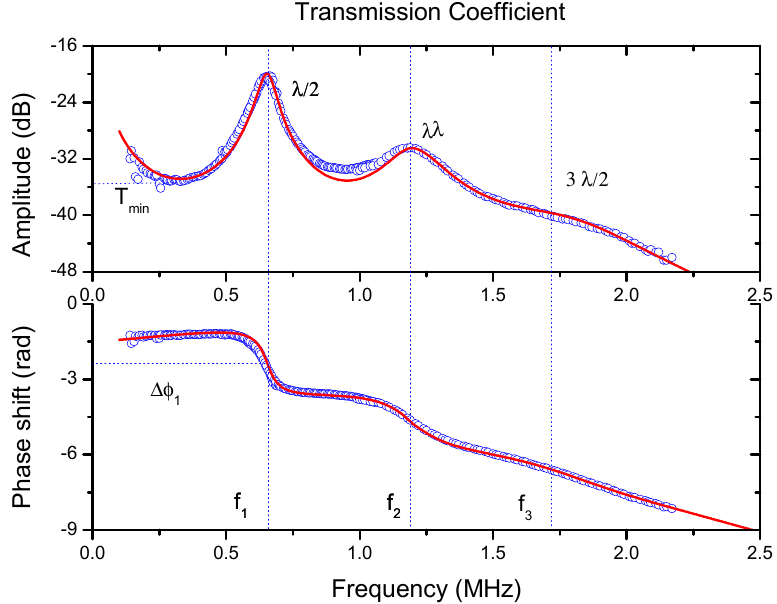
Figure 6. Spectra of the transmission coefficient of the PP film used for this work measured (blue circles) by air-coupled and wide-band ultrasonic transducers and calculated according to Equation (1): solid red